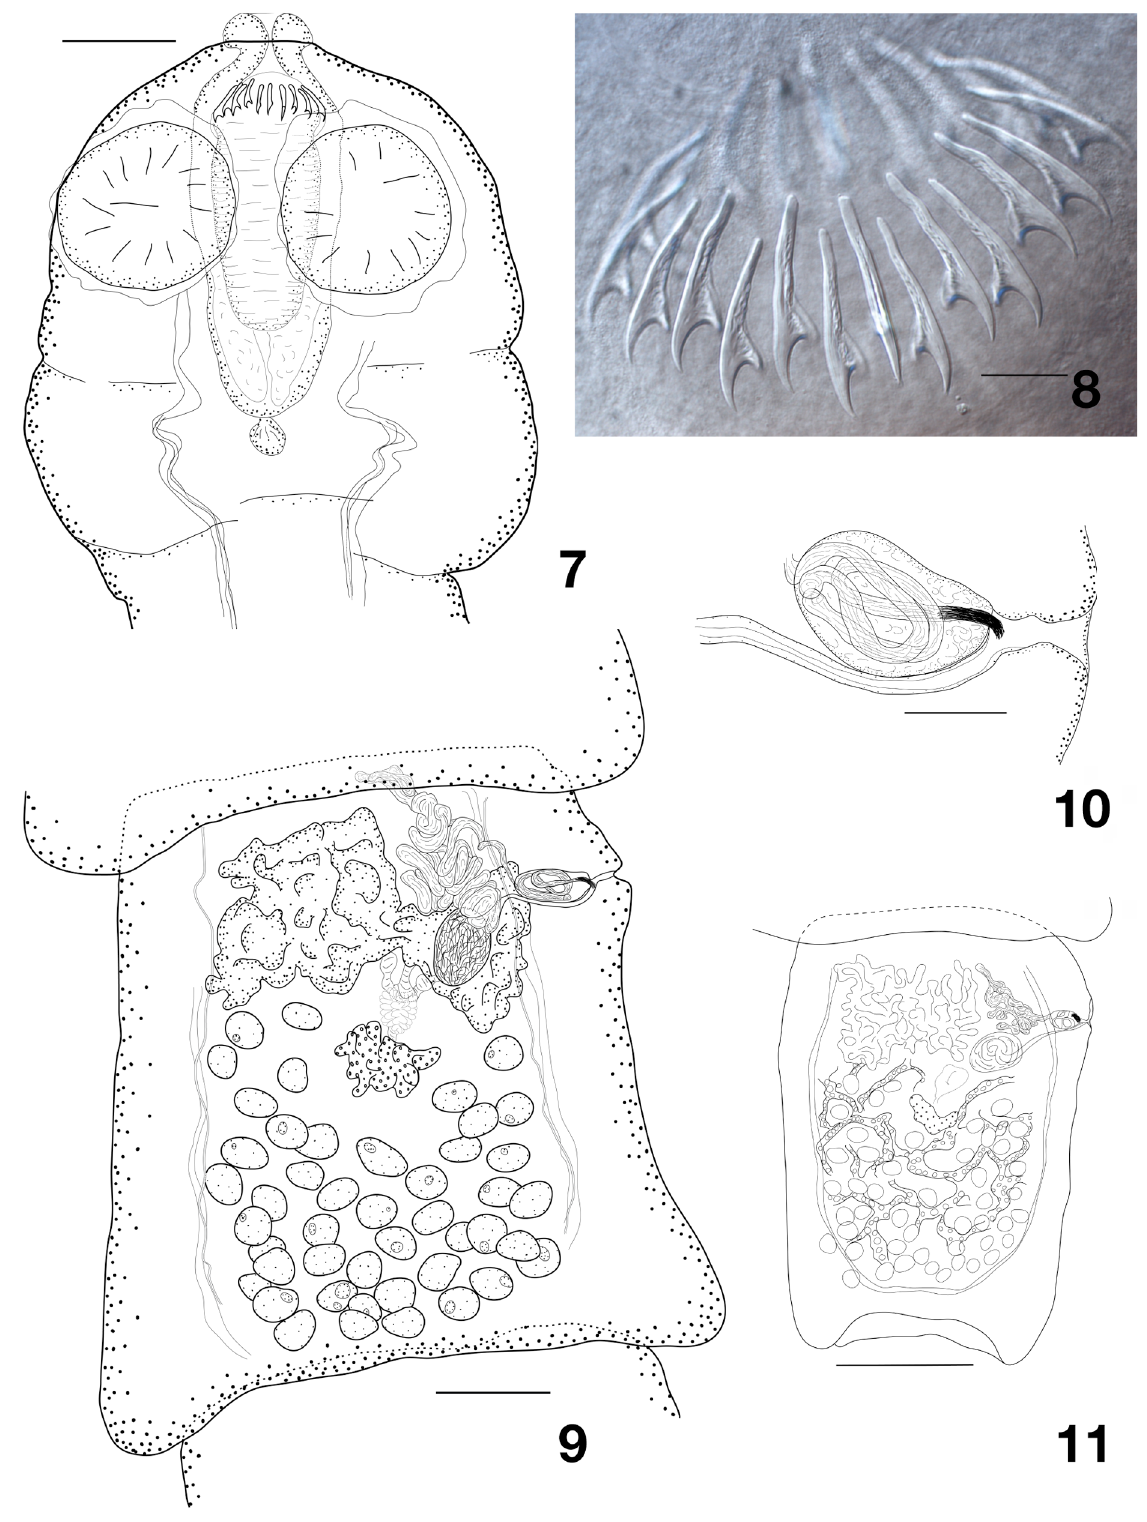
Figs 7–11. Spiniglans beveridgei sp. nov. 7 . Scolex. 8 . Hooks. 9 . Mature proglottis. 10 . Terminal genitalia. 11 . Pregravid proglottis with young reticular uterus. Scale bars: 7 = 100 µm; 8 = 20 µm; 9 = 200 µm; 10 = 50 µm; 11 = 500